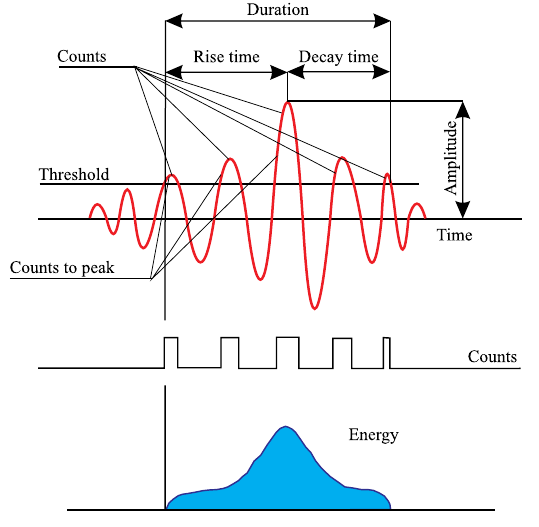
Fig. 1. An idealized AE signal